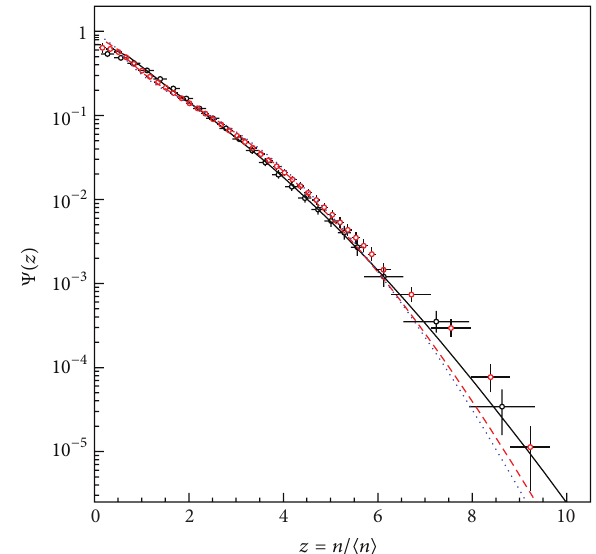
Figure 13: The charged hadron multiplicity distributions in KNO form at √𝑠 𝑁𝑁 = 0.9 TeV and 7TeV in pseudorapidity interval, |𝜂| < 2.4 along with comparison to the experimental data. The figure is taken from [65].